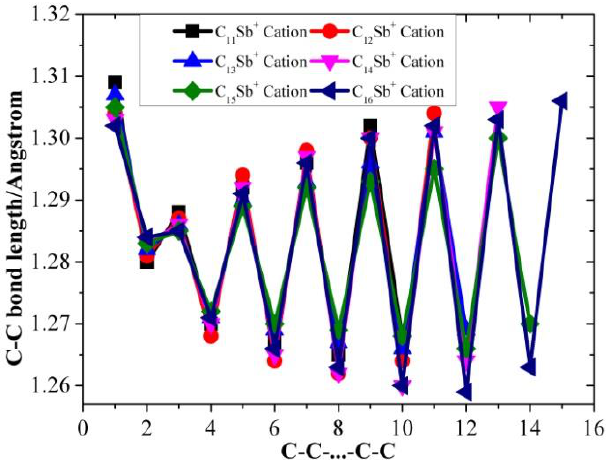
Figure 3. C-C bond length alteration of neutral C n Sb ( n = 11 – 16) as a function of number of carbon atoms.